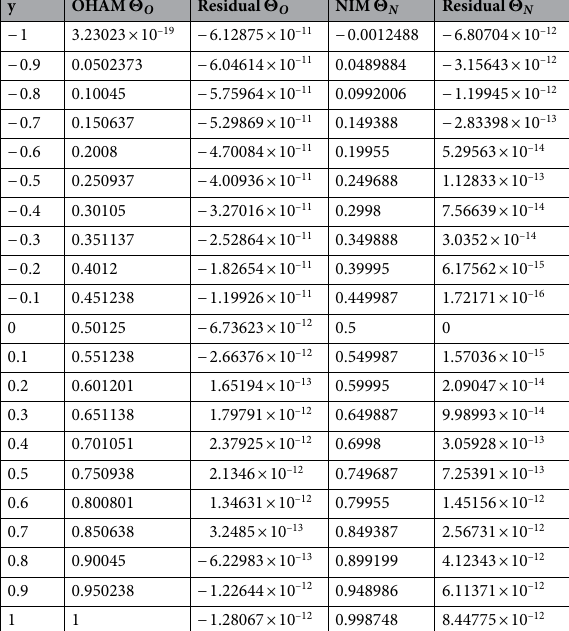
Table 2. For A = 0.002, B = 0.1, M = 0.00015 and (cid:31) = 0.01.